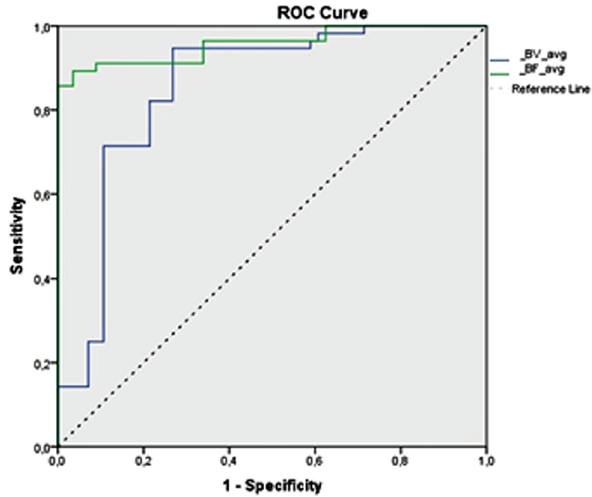
Figure 4: Receiver operating characteristic ( ROC ) curve analysis for blood fl ow ( BF ) and blood volume ( BV ) perfusion parameters. BF value less than 98.443 mL min − 1 100 g − 1 ( area under the curve [ AUC ] = 0.957 ) and BV value less than 14.319 mL 100 g − 1 ( AUC = 0.852 ) are shown to be good predictors for the presence of PDAC.